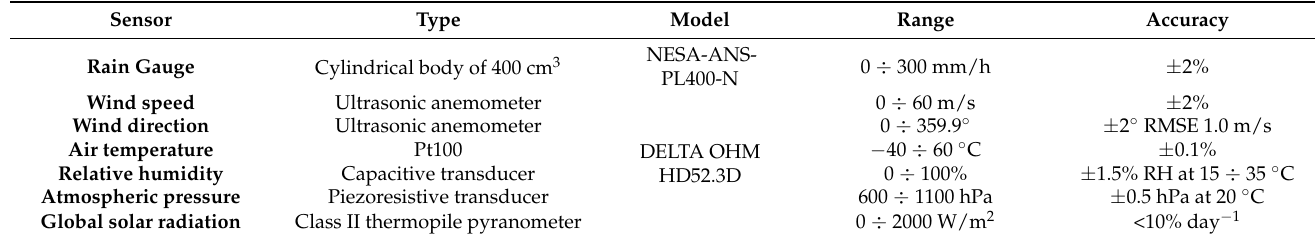
Table 2. Technical specifications of the external climatic